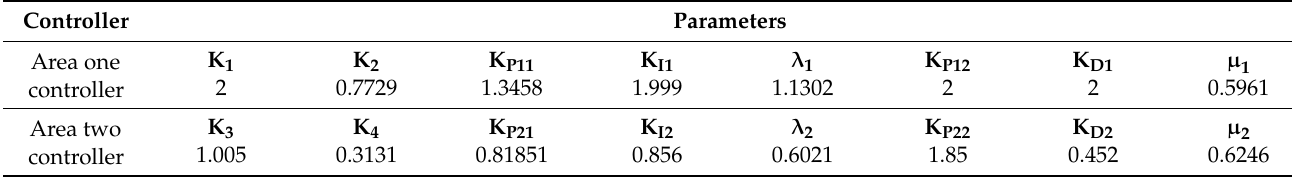
Table 3. Optimal gains of FC FOPI-FOPD obtained by PSO.